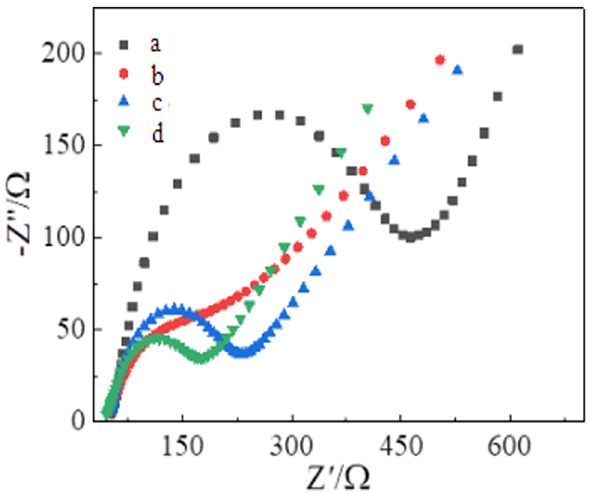
Figure 13: EIS map of CNTs, GCB, GCC, and GCBC composite sam - ples. Pure CNTs ( a ) , GCB ( b ) , GCC ( c ) , and GCBC ( d )